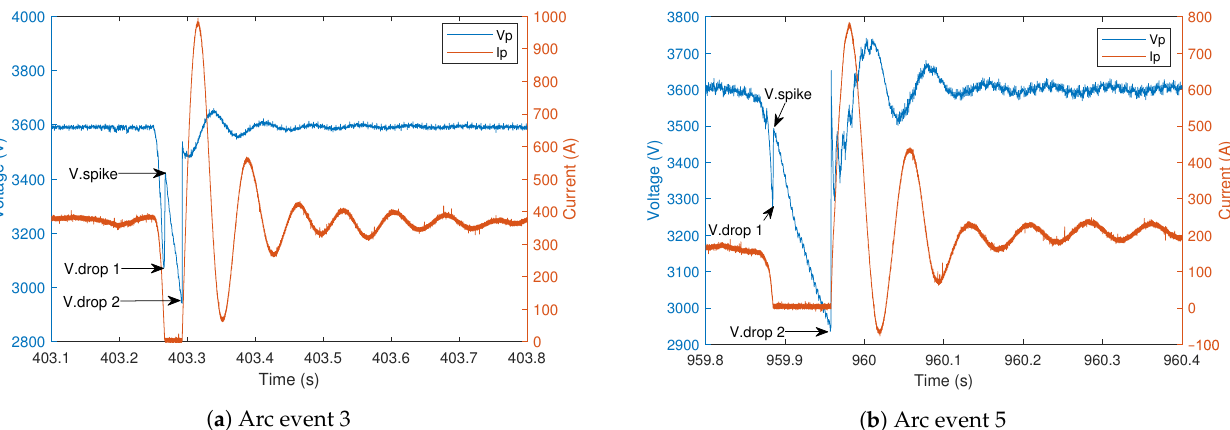
Figure 1. Time domain representation of pantograph voltage V p and pantograph current I p during arc event 3 and 5 occurred in a coasting phase.